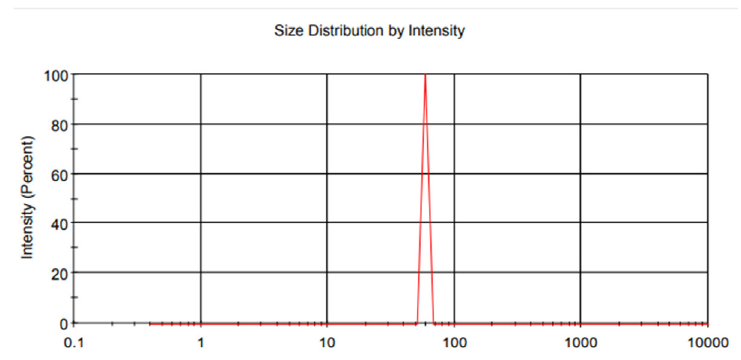
Fig. 11. Particle Size Distribution of